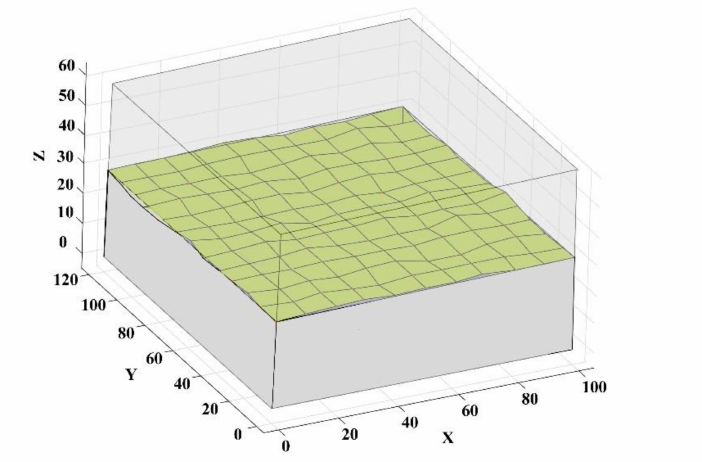
Figure 4. Simulated milled surface (uncertainty amplified 30